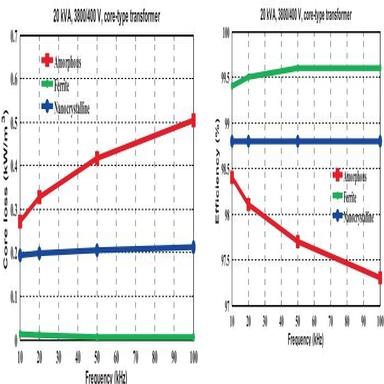
20 kVA, 3800/400 V, core-type transformer. (a) Core loss (kW/m3 ) versus frequency (kHz); (b) Efficiency (%) versus frequency (kHz).